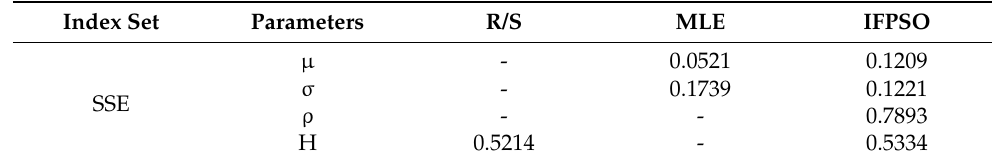
Figure 3. Comparison of SSE index results of algorithm optimization search. ( a ) PSO, ( b ) IFPSO. Table 2. MFBM model parameters and optimization results for the SSE index.